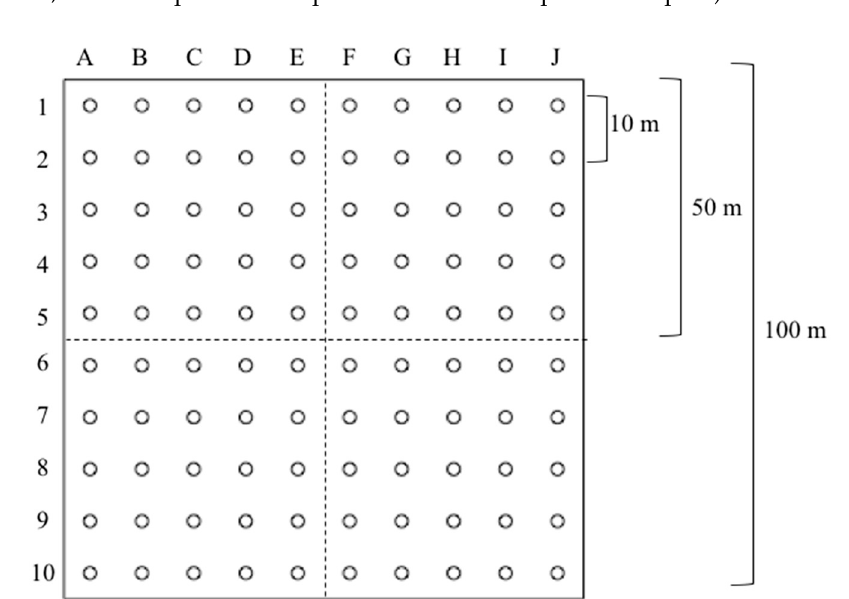
Figure 2. Layout of small mammal plots and subplots in northern Wisconsin, USA, with identification letters and numbering scheme as well as measurements. Traps are identified as circles (10 m apart) and subplots (n = 4, 50 m 2 ) are identified as black dashed lines within the larger black square plot (100 m 2 ). The trap grids are identified horizontally alphabetically and vertically numerically.